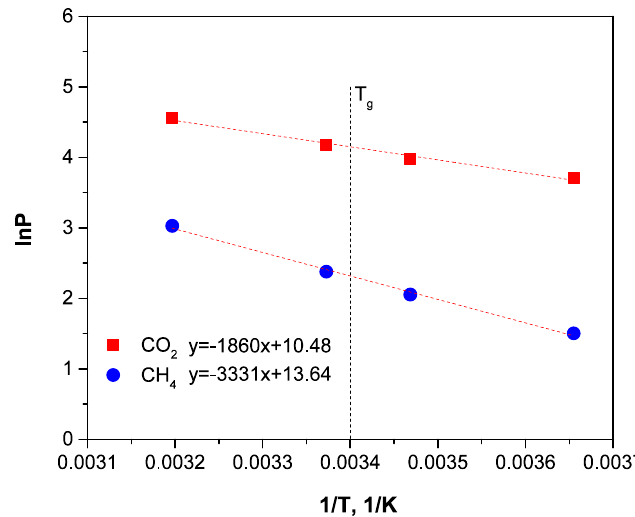
Figure 7. Temperature-dependent permeability coefficient of the tape-woven fabric membrane module for CO 2 and CH 4 in the mixture (50/50%vol.). Table 4. Apparent activation energies of the gas permeability for different lab-scale membrane mod- ules.